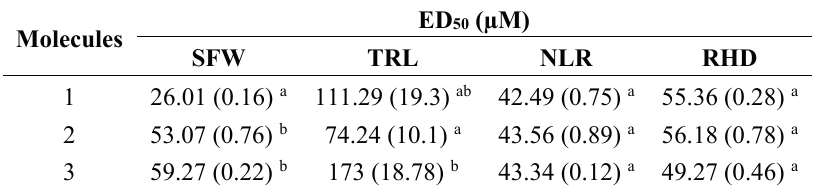
Table 2. ED 50 (µM) values of shoot fresh weight (SFW), total root length (TRL), number of lateral root (NLR) and root hair density (RHD) of A. thaliana estimated by the log-logistic equations in response to different concentrations of 1 – 3 . Data from Figures 1 and 3.